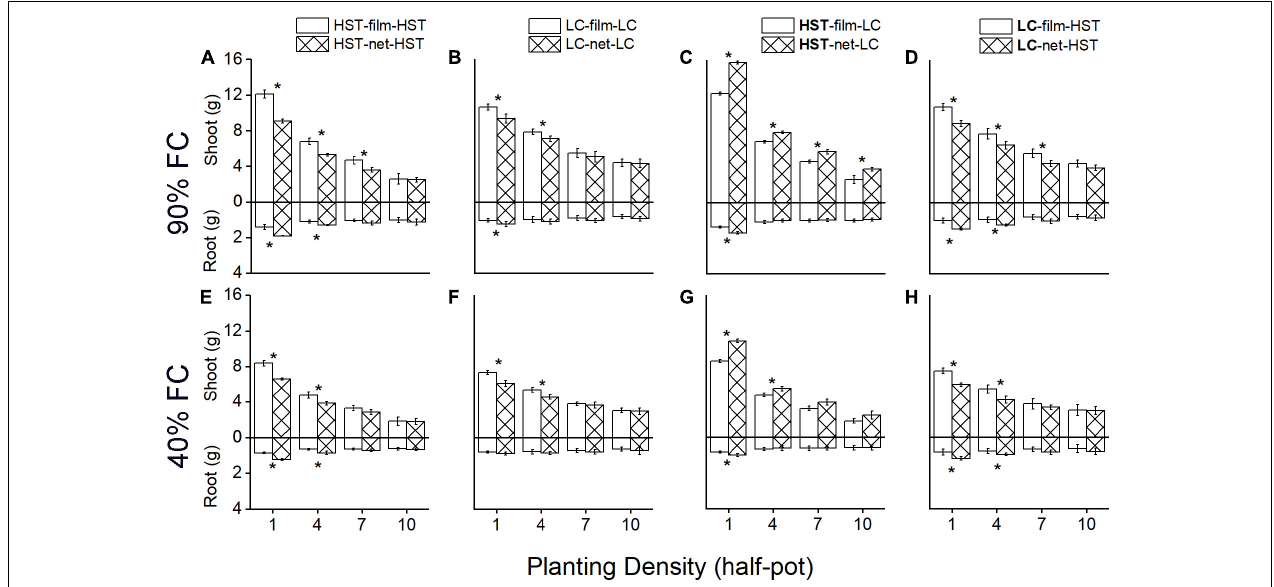
FIGURE 4 | Mean root and shoot (stems plus leaves and spike) mass per plant of two cultivars in the pot experiment. Panels (A–D) are at 90% field capacity (FC), panels (E–H) are at 40% FC. Panels (A,B,E,F) are cultivars HST and LC in monoculture. Panels (C,D,F,G) are HST and LC in mixture. In the mixtures, the cultivar in bold is the target plant; soil dividers: “film”’ or “net.” All values are grams dry mass per individual. The error bars indicate one standard error above and below the mean. The asterisks indicate significant differences between two soil